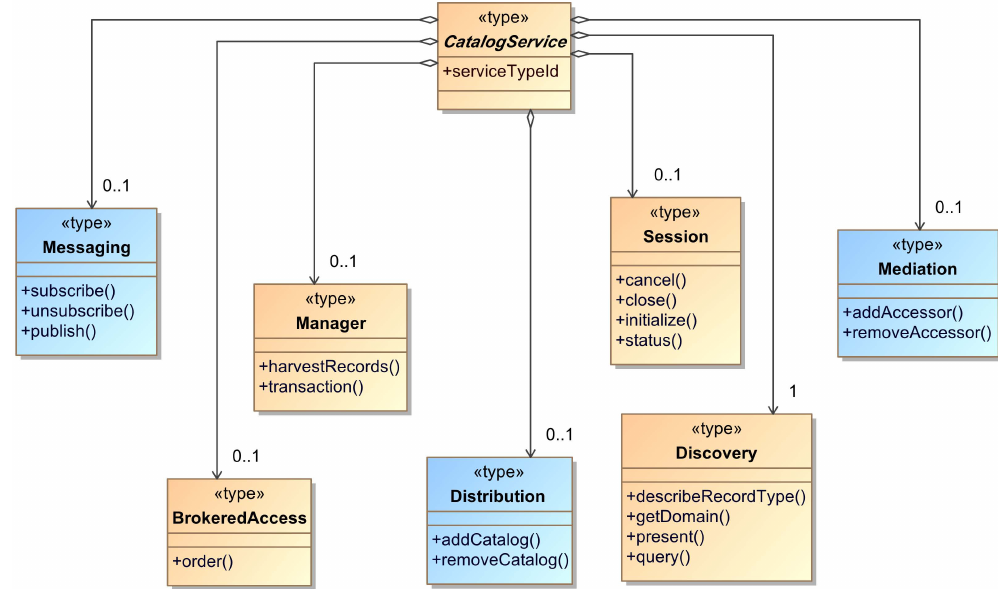
Fig. 2. Extended interface functional model for distributed catalog service with mediation